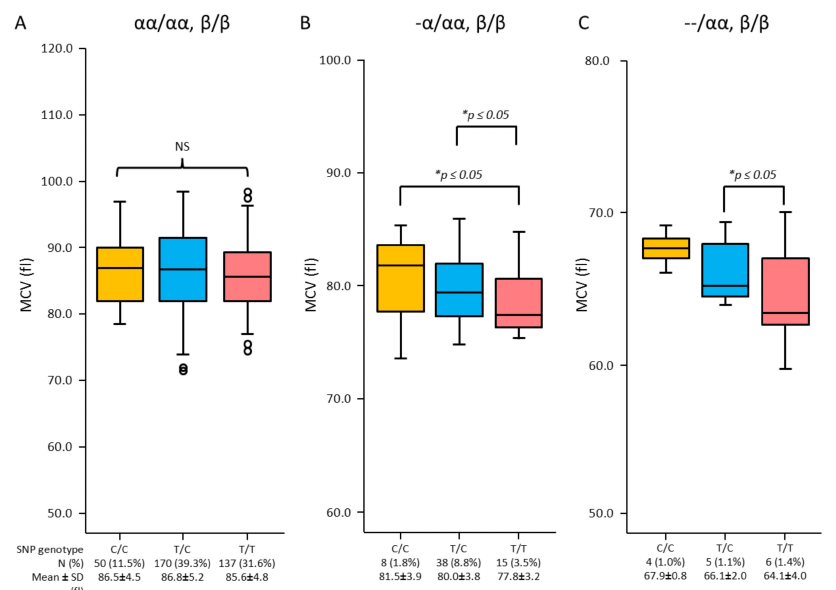
Figure 2. Characteristics of MCV among SNP rs855791 genotypes (C/C, T/C, T/T) of TMPRSS6 in the population of normal α -globin gene ( αα / αα ) ( A ), α + -thal (- α / αα ) ( B ) and α o -thal (–/ αα ) ( C ) (*significant difference at p -value ≤ 0.05 from independent t -test; NS, non-statistical significance at p > 0.05).